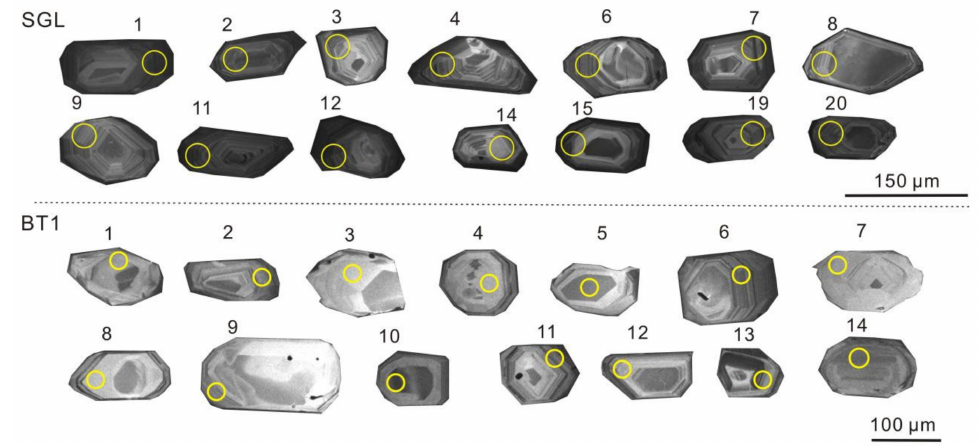
Figure 5. Cathodoluminescence (CL) images of zircons from the host Sanguliu granodiorite and monzodioritic enclaves.